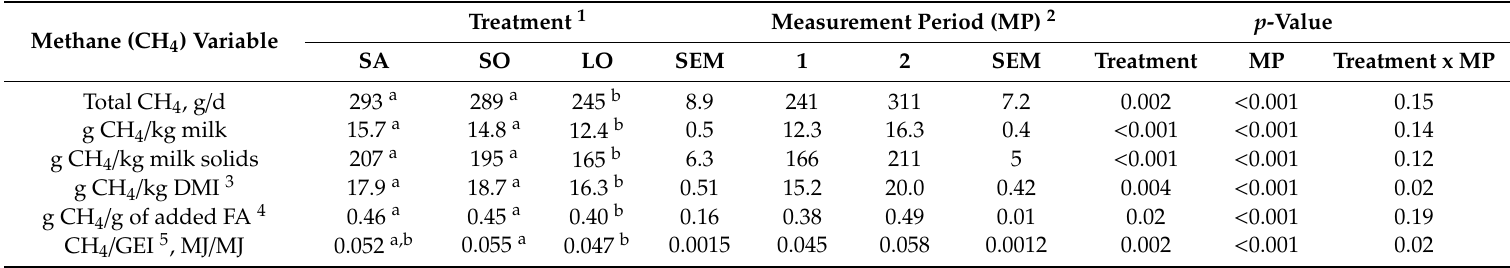
Table 5. E ff ect of C 18 fatty acid source in the supplementary concentrate and measurement period on methane emissions from lactating dairy cows o ff ered a pasture based diet (least square means ± SEM).